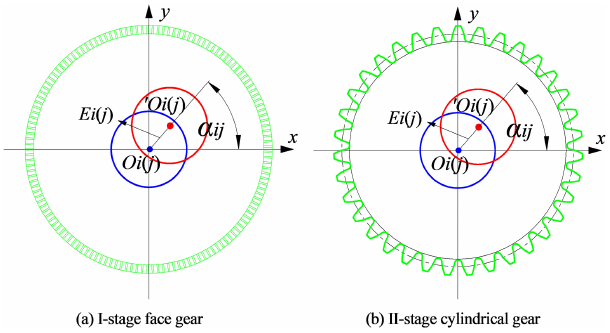
Figure 6. Diagram of the eccentricity error.